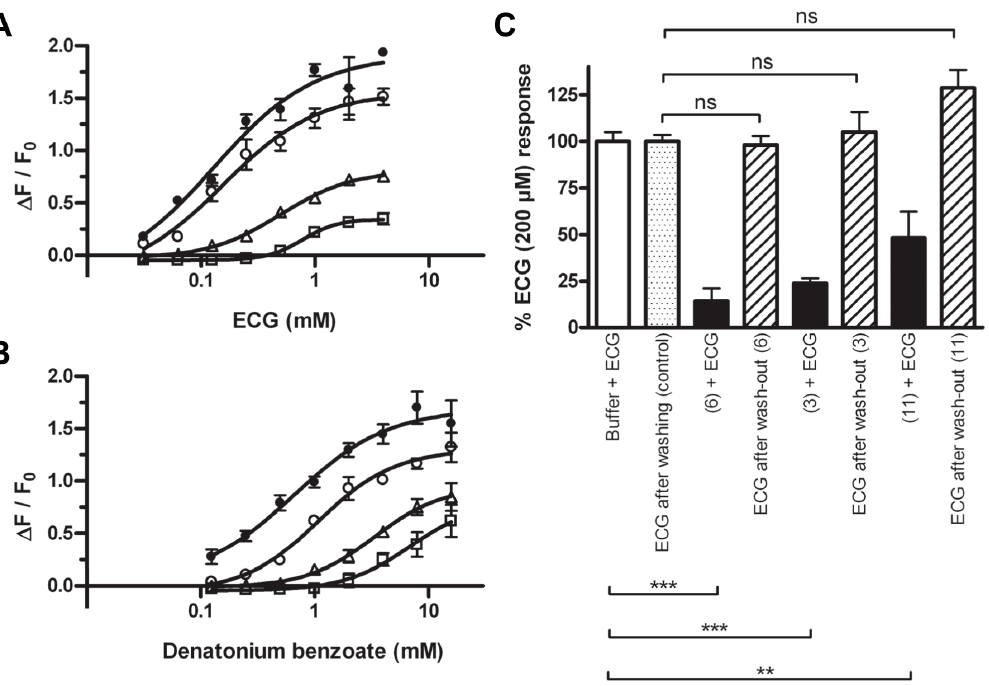
N N Figure 8. Dose-response curves for epicatechin gallate (ECG) ( ) (n=2) (A) and denatonium benzoate ( ) (n=2) (B) on hTAS2R39, and their modification by increasing 4 9 -fluoro-6-methoxyflavanone (6) concentrations ( # 50 m M, D 100 m M, % 200 m M). Antagonist and agonist were added in the stepwise way. Data are presented as mean 6 SEM of n separate experiments conducted in duplicate. Wash-out experiments (n=2) (C). Cells were stimulated with 200 m M ECG in the absence (open bars) and in the presence (filled bars) of 100 m M 4 9 -fluoro-6- methoxyflavanone (6), or 500 m M 6,3 9 -dimethoxyflavanone (3), or 500 m M 6-methoxyflavanone (11), washed with Tyrode’s buffer, and again stimulated with 200 m M ECG (hatched bars; control: grey bar). Antagonist and agonist were added in the stepwise way. Data are presented as mean 6 SEM of n separate experiments conducted in quadruplicate. Significance of signal reduction is indicated by *** (p # 0.001), ** (p # 0.01), and n.s. (not significant, p . 0.05).